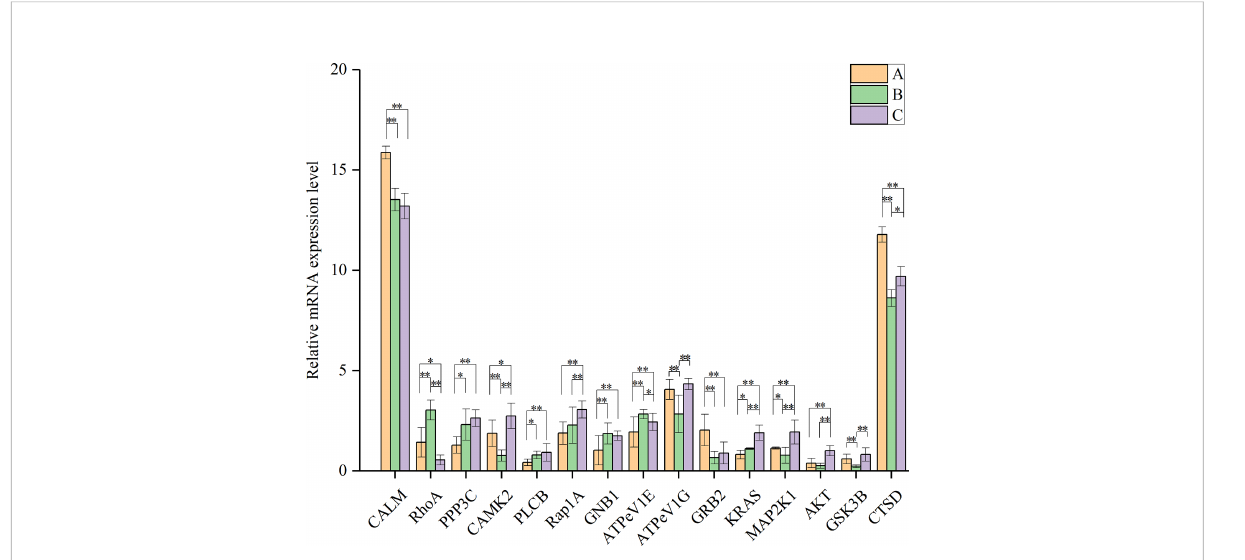
FIGURE 10 Relative mRNA level of genes encoding proteins involved in aging-related pathways. CALM: calmodulin; RhoA: Ras homolog gene family, member A; PPP3C: serine/threonine – protein phosphatase, catalytic subunit; CAMK2: calmodulin – dependent protein kinase II; PLCB: phospholipase C, beta; Rap1A: Ras – related protein 1A; GNB1: guanine nucleotide-binding protein, subunit beta – 1; ATPeV1E: V – type H + – transporting ATPase subunit E; ATPeV1G: V – type H + – transporting ATPase subunit G; GRB2: growth factor receptor – binding protein 2; KRAS: GTPase KRas; MAP2K1: mitogen – activated protein kinase kinase 1; AKT: RAC serine/threonine – protein kinase; GSK3B: glycogen synthase kinase 3 beta; CTSD: cathepsin D. “ * ” and “ ** ” indicate signi fi cant differences at P <0.05 and P <0.01, respectively. Data are presented as mean ± S.D. from three independent biological